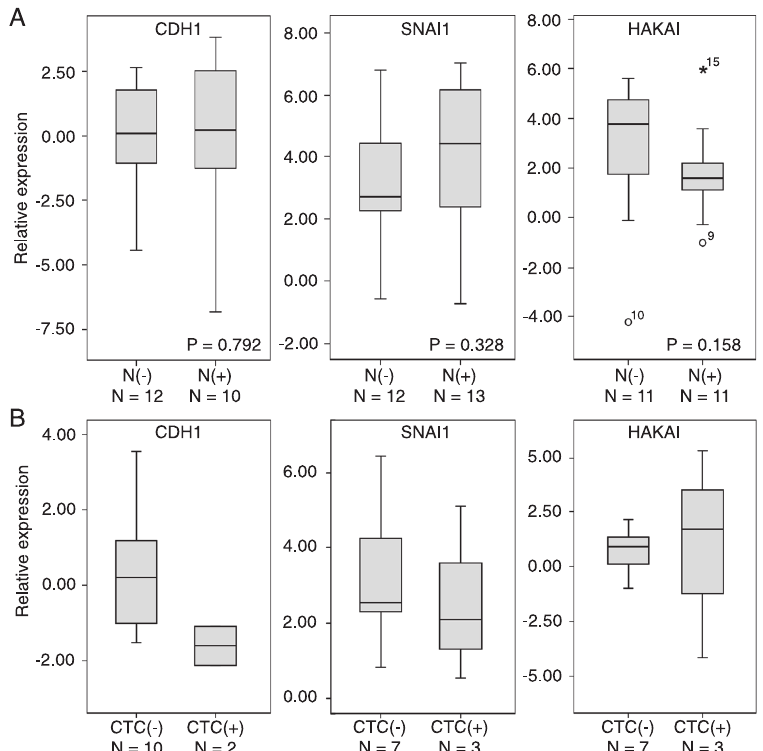
Figure 4. A , CDH1, SNAI1, and HAKAI mRNA expression in tumor specimens according to the presence [N(+)] or absence of lymph node involvement [N(-)]. Boxplots display the distribution of all values between bars (25th, 50th and 75th percentiles in the box), except outliers (circles, 1.5-3.0 box lengths from the 75th quartile; asterisks, >3.0 box lengths from the 75th percentile). No differences were observed (Mann-Whitney test). B , CDH1, SNAI1, and HAKAI mRNA expression in tumor specimens according to the presence of circulating tumor cells (CTC) [presence (+) or absence